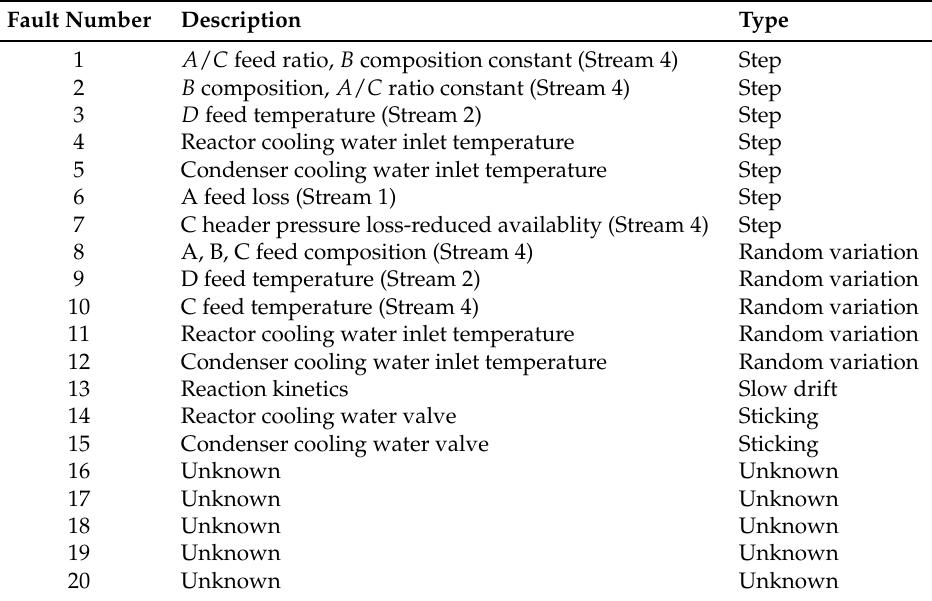
Table 1. Fault description of the TEP simulation [45].